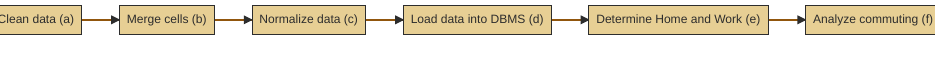
Figure 5. Workflow of the data